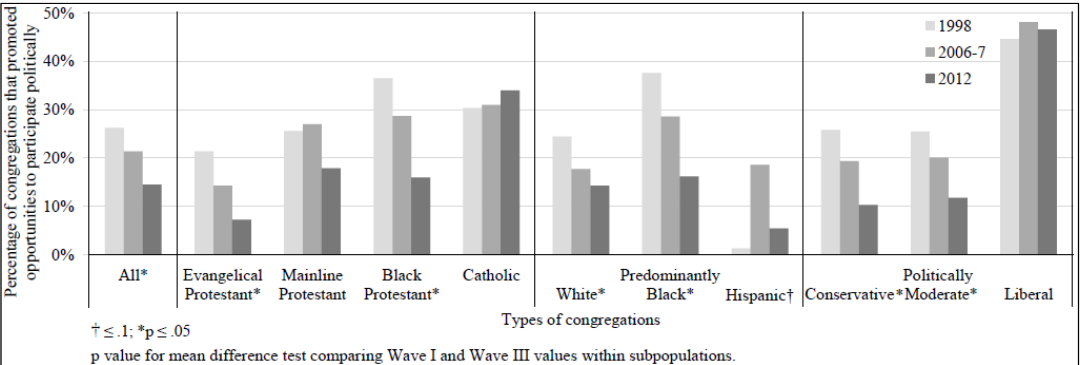
Figure 6. The percentage of congregations by subpopulation that promoted opportunities to participate politically by wave.